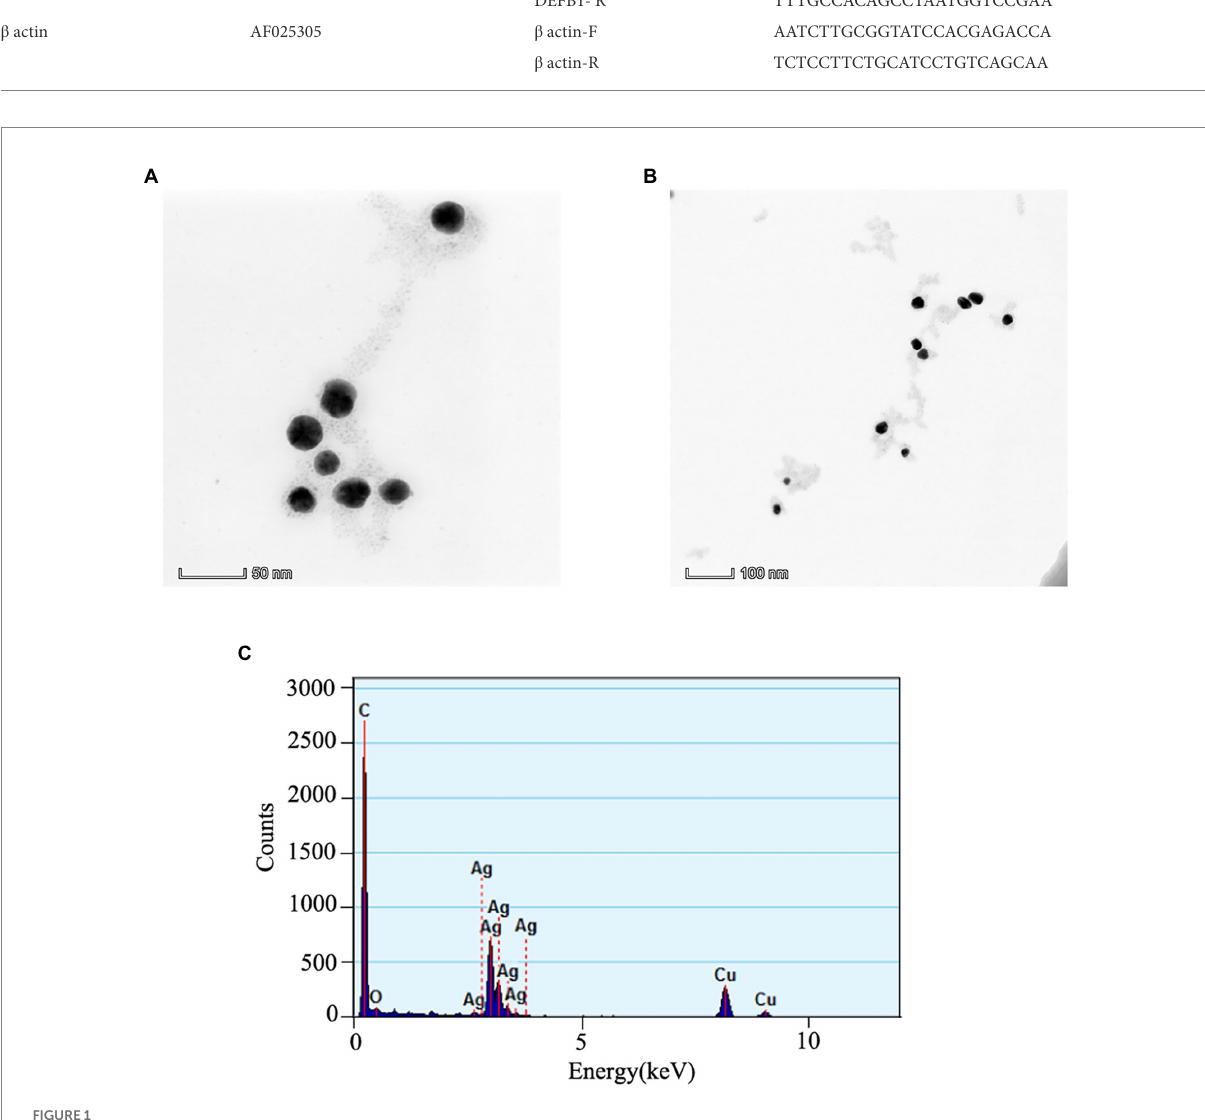
FIGURE 1 The TEM images of AVH-AgNPs at 50 nm (A) , 100 nm (B) ruler magnification and EDX spectrum acquired at 200 kV (C)